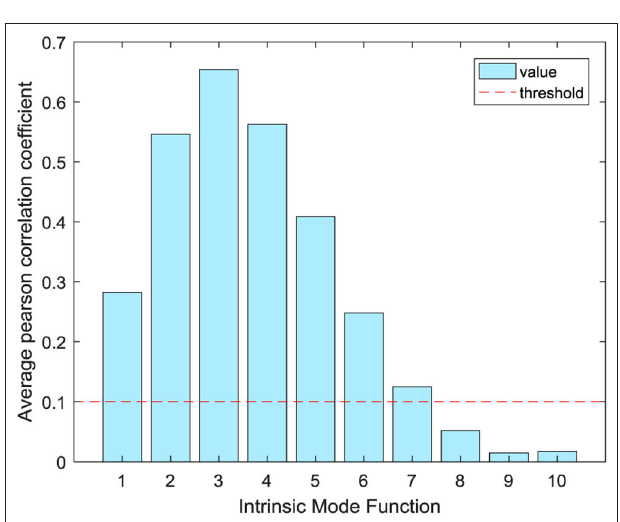
FIGURE 5 | Correlation between IMF components of all channels and raw